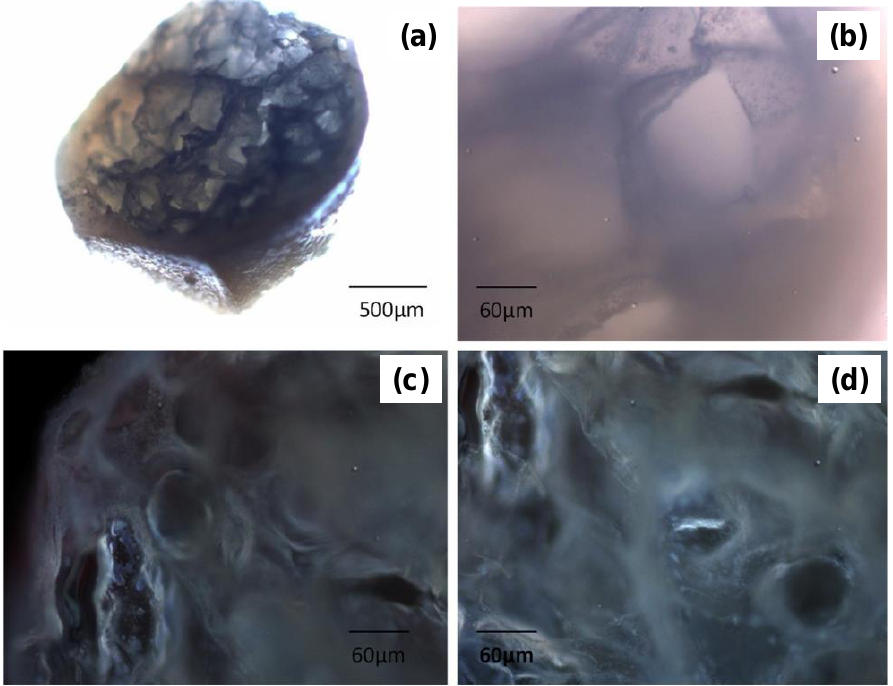
Figure 14. Microphotographs obtained using bright-field ( a , b ) and fluorescent microscopy ( c , d ) showing the presence of pores and air bubbles entrapped within the gel matrix of hydrated beads, able to confer their floating ability in SGF. Reprinted from [206] with permission from Elsevier. Copyright (2018).